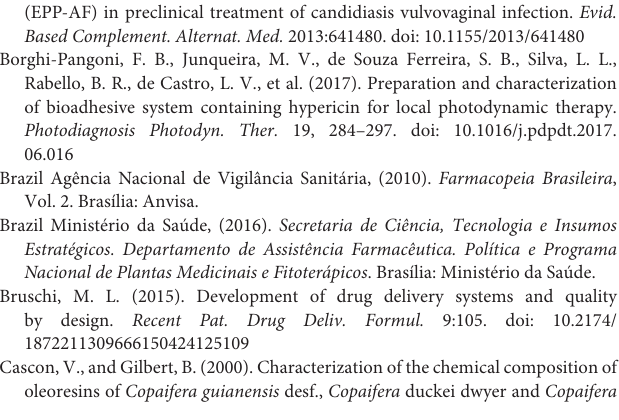
FIGURE S1 | Representative mass spectra profile of acid diterpenes (copalic, hardwickiic and kaurenoic acids) from Copaifera officinalis oleoresin. FIGURE S2 | Antibacterial activity of carbomer-based hydrogels with different pHs on growth of S. agalactiae ATCC 13813. The bacteria were incubated with CARB-BF (B,C) and CARB-CO 1.0 (D,E) , in pHs 5.5 (B,D) and 7.0 (C,D) during 24 h at 37 o C. GBSs without treatment (A) were used as growth